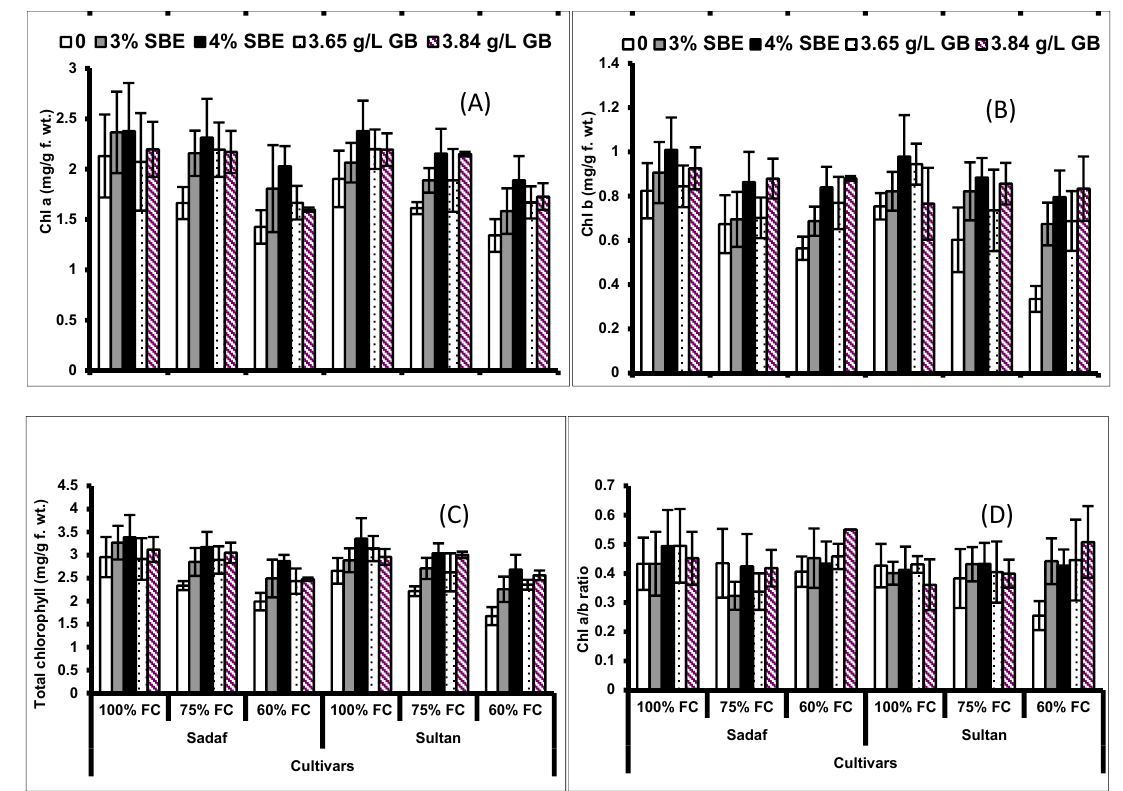
Figure 2. ( A ) Chlorophyll a (Chl a), ( B ) chlorophyll b (Chl b), ( C ) total chlorophyll and ( D ) chlorophyll a/b of two maize cultivars foliar-fed with varying levels of sugar beet extract (SBE) and glycine betaine under water deficit conditions (Mean ± S.E.). Drought induced a significant ( p ≤ 0.001) increase in RMP of both maize cultivars.